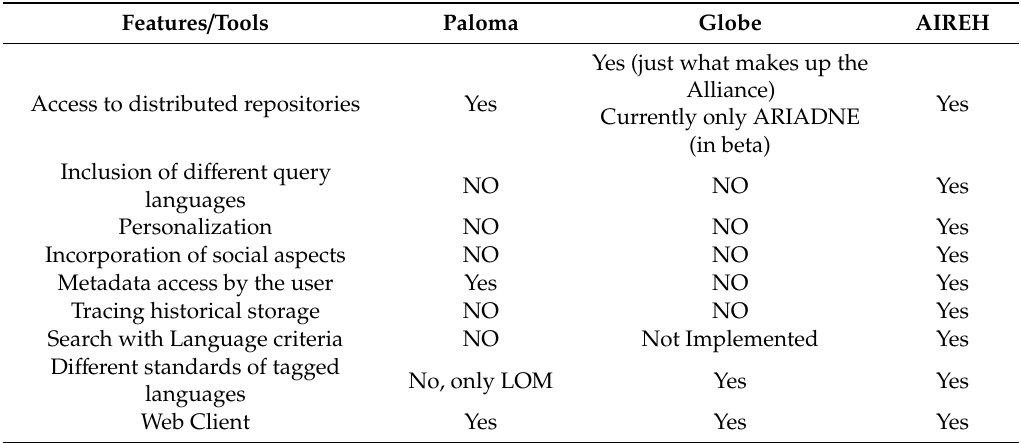
Table 2. Comparative of the characteristics of the LO federated search